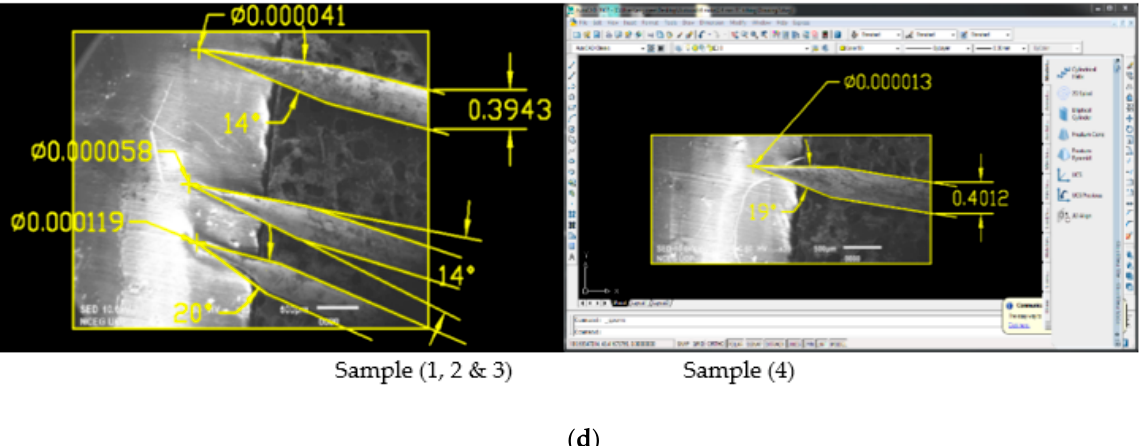
Figure 1. ( a ) Scanning electron microscope (SEM) and Optical Microscope (OM) Images of 0.4 mm tungsten tips prepared in 2 Molar NaOH solution (16 g/200 mL); ( b ) SEM and OM Images of 0.4 mm tungsten tips in 2 molar NaOH solution showing cone angle and tip diameter measured using AutoCAD Software; ( c ) SEM Images of 0.4 mm tungsten tips prepared in 4 Molar NaOH solution (32 g/200 mL); ( d ) SEM Images of 0.4 mm tungsten tips in 4 molar NaOH solution showing cone angle and tip diameter measured using AutoCAD Software.